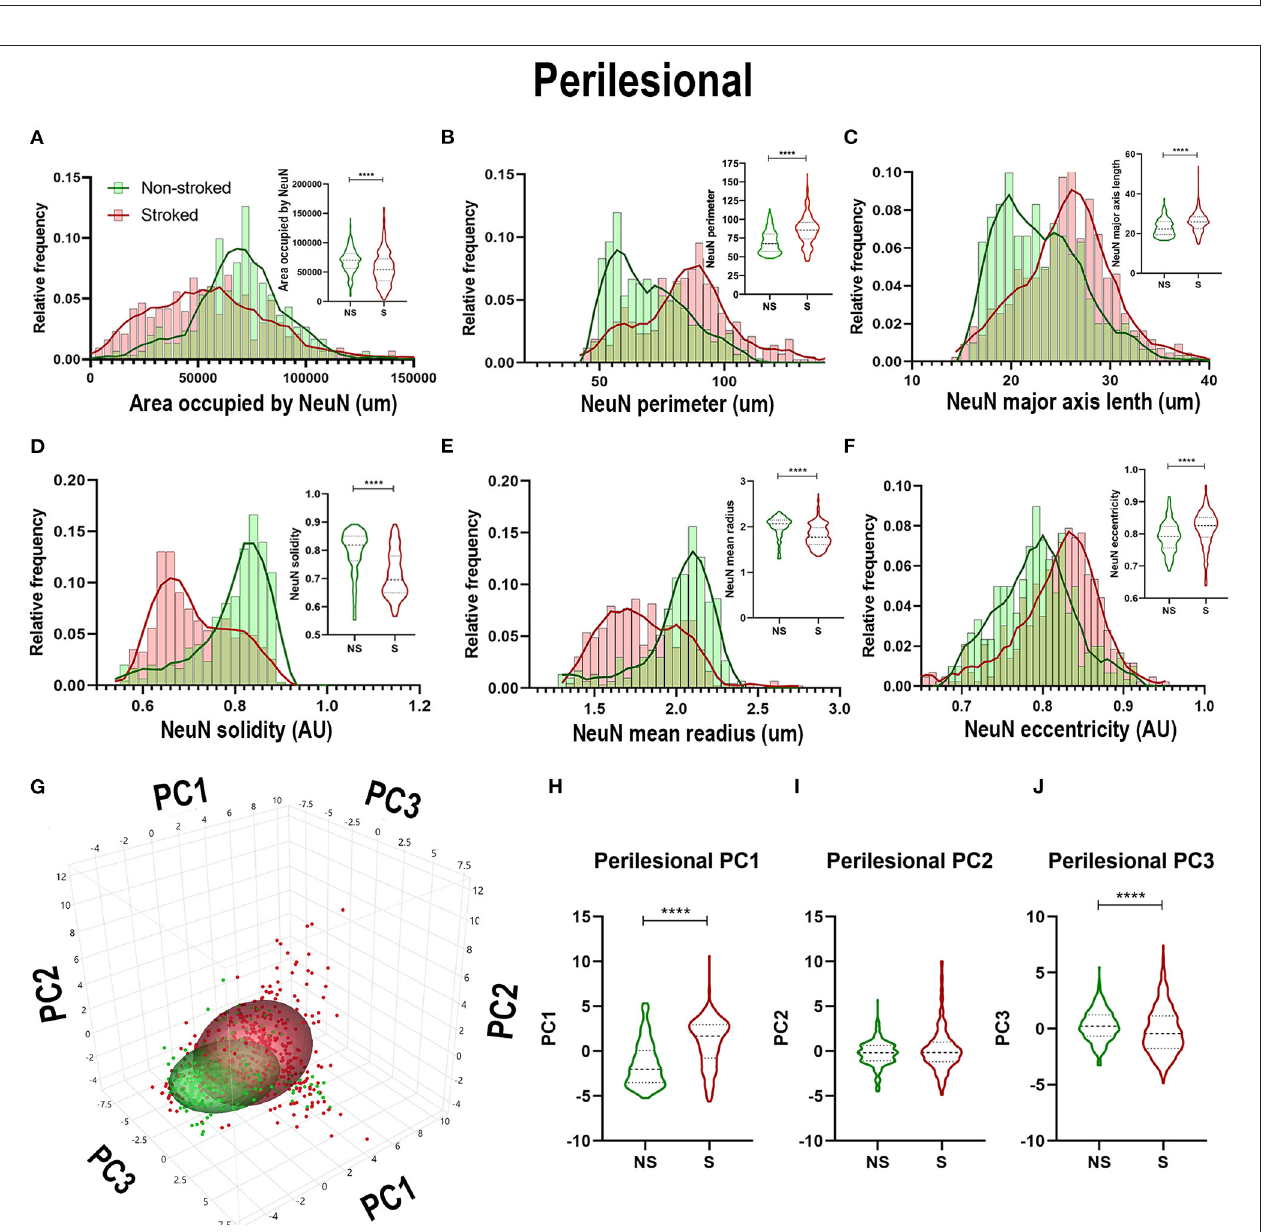
FIGURE 7 | NeuN + morphological changes in perilesional tissues differed from those in the larger ipsilateral hemisphere. Significant ( p < 0.0001) decreases in NeuN + area occupied (A) , perimeter (B) , solidity (D) , and mean radius (E) were observed in ROIs of S ( n = 452 ROIs) animals compared NS ( n = 354 ROIs) animals. Significant ( p < 0.0001) increases in major axis length (C) and eccentricity (F) were observed in S animals compared to NS animals. PCA (G) analysis showed a significant ( p < 0.0001) increase in PC1 (H) and decrease in PC3 ( J ; p < 0.0001) between S and NS animals, but no significant difference was observed in PC2 (I) . **** p <